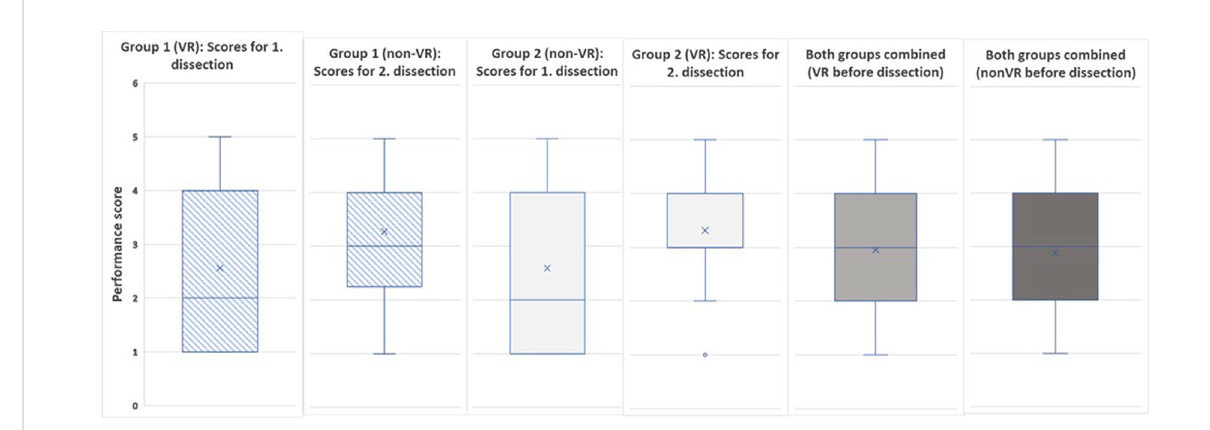
FIGURE 5 The dissection performance scores (OSATS) for both days and combined.